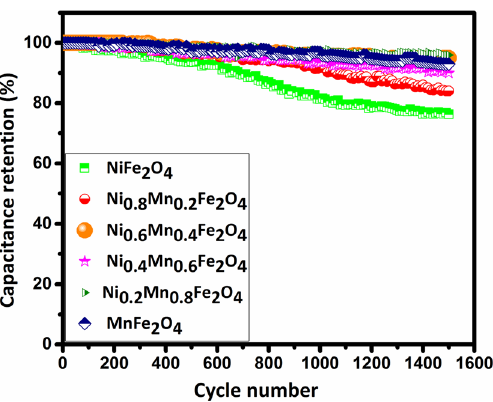
Figure 14. Cycling stabilities of the electrodes constructed from the prepared Ni 1−x Mn x Fe 2 O 4 nanoparticles over 1,500 GCD cycles at the current density of 3